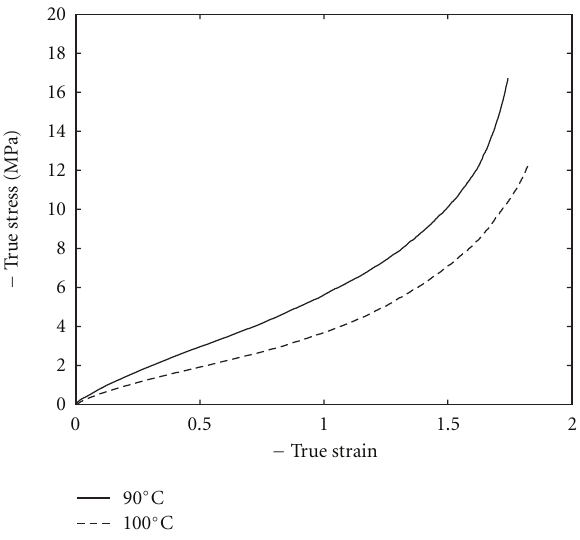
Figure 3: Temperature comparison, PET00, and uniaxial compres- sion at 0.1/s.